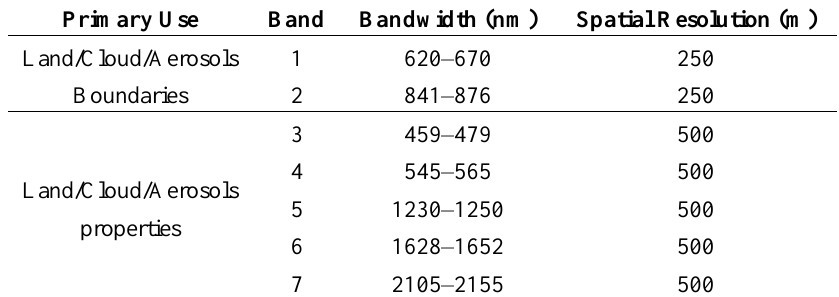
Table 1. Characteristics of the MODerate Resolution Imaging Spectroradiometer (MODIS) bands used in the present